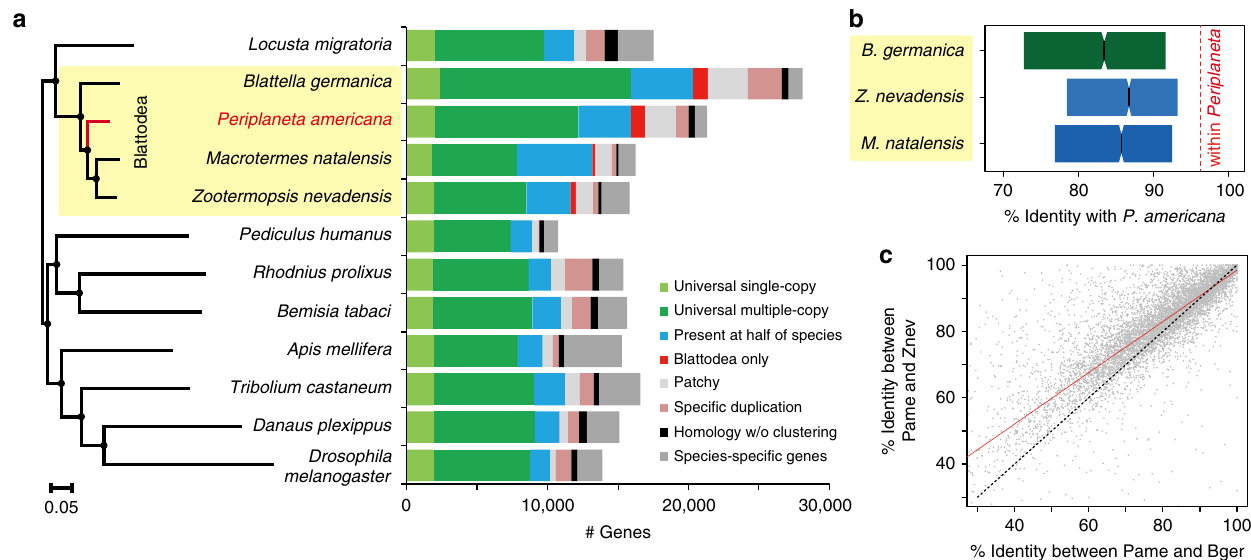
Fig. 1 Orthology and genome evolution of Blattodea. a Orthology assignment of four blattodean species and eight other representative insect species (Supplementary Table 6). Bars are subdivided to represent different types of orthology clusters as indicated. Universal groups represent common gene families across all species analyzed, but absence in at most one genome is tolerated; of them, “ single-copy ” tolerates absence or duplication in a single genome, while “ multiple-copy ” indicates other universal genes. “ Blattodea only ” indicates unique presence to the blattodean lineage and in at least three genomes. “ Speci fi c ” groups indicate speci fi c presence or duplication in only one species. “ Homology ” indicates partial homology detected with E < 10 − 5 but no orthology grouped. Remaining orthologs were assigned to “ Present at half of species ” or “ Patchy ” , depending on whether presence is in at least six genomes or not. The phylogeny was calculated using maximum-likelihood analyses of a concatenated alignment of 538 exactly single-copy proteins. The tree was rooted using the sister clades of Blattodea and Orthoptera species as described previously 70 . Bootstrap values based on 100 replicates are equal to 100 for each node. b Distribution of sequence identities. The boxplots delineate the interval between the fi rst and the third quartiles of the identity distribution between P. americana and one indicated blattodean species. Notch indicates the median value. Amino acid sequence identity was calculated based on multiple alignment of each universal single-copy ortholog (5911 in total) in four blattodean species. The red dashed line indicates the median value within Periplaneta species (96%). c Comparison of sequence identities on each ortholog cluster. A total of 7640 1:1:1 orthologs were identi fi ed among P. americana , B. germanica , and Z. nevadensis . Each dot represents such an ortholog. Value on x -axis indicates the sequence identity between P. americana (Pame) and B. germanica (Bger), while value on y -axis indicates that between P. americana and Z. nevadensis (Znev). Red line indicates the smoother of a locally weighted regression, with the coef fi cient of determination as 0.99999. Dashed line indicates positions where the sequence identity between P. americana and B. germanica is identical to that between P. americana and Z.